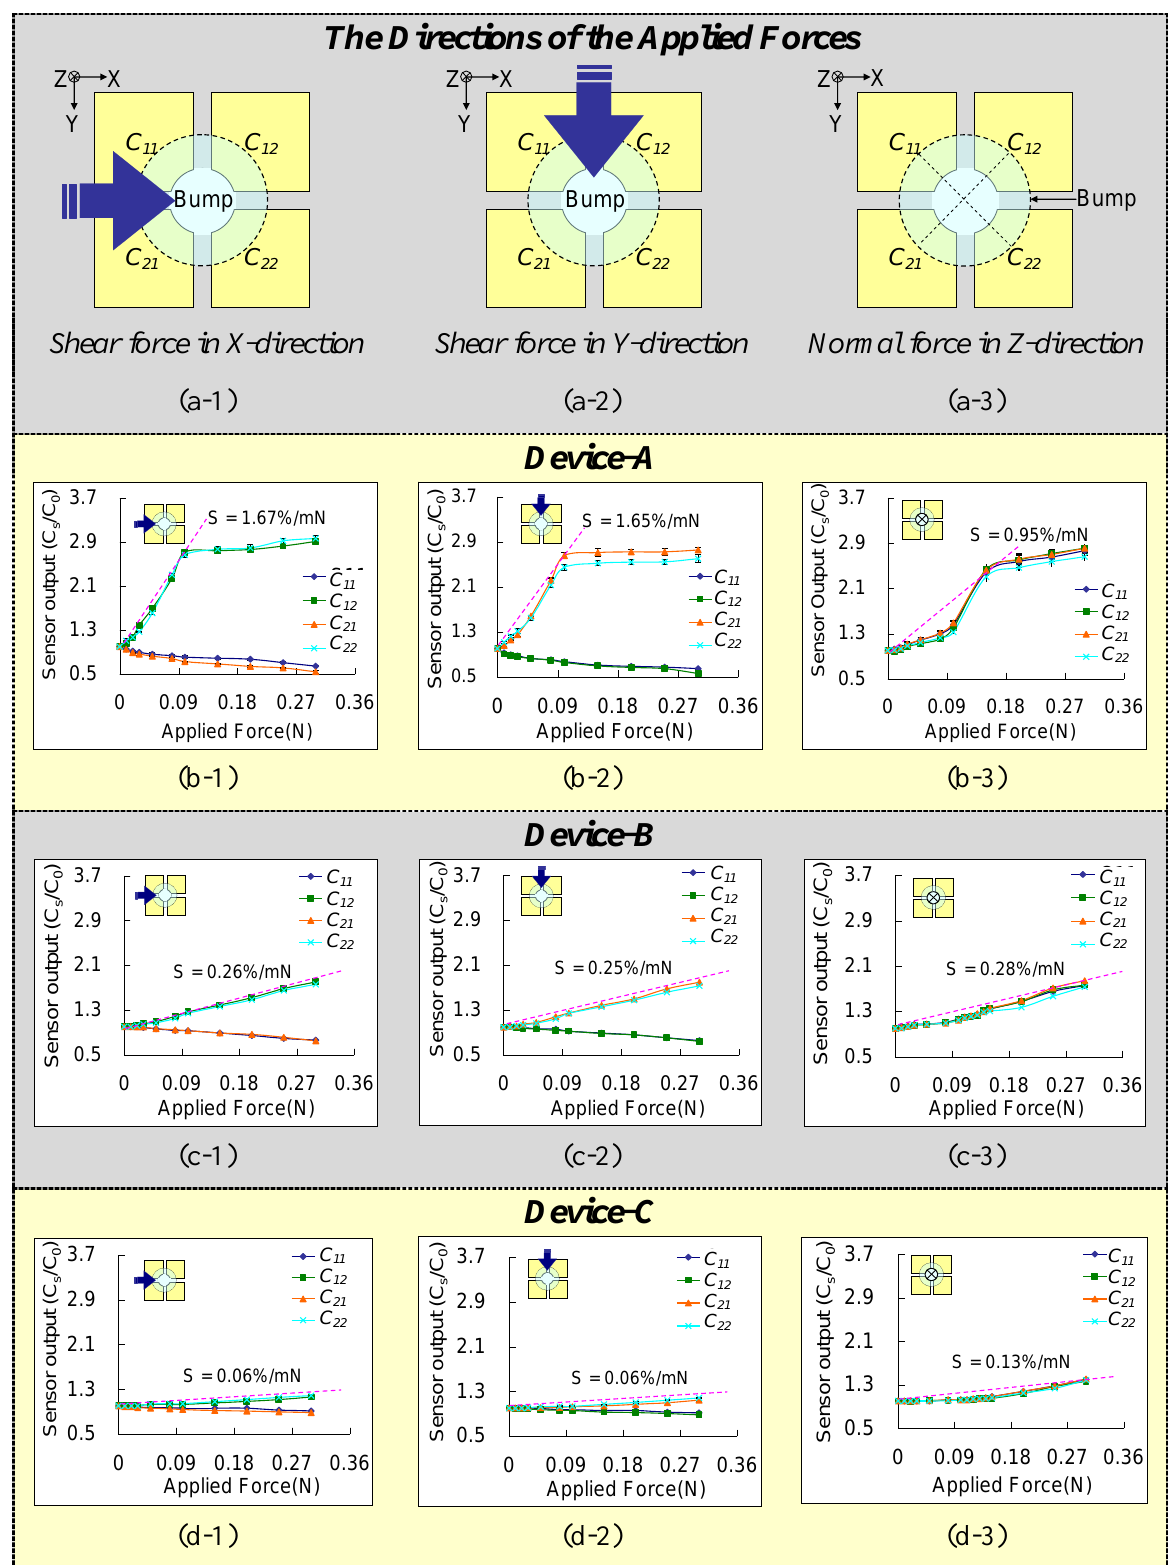
Figure 8. The measured relationships of capacitance vs. applied force (N) for three sensing elements with different thicknesses of Layer-II (Device-A, Device-B and Device-C). (a) The directions of the applied forces. (b) The measured results for Device-A. (c) The measured results for Device-B. (d) The measured results for